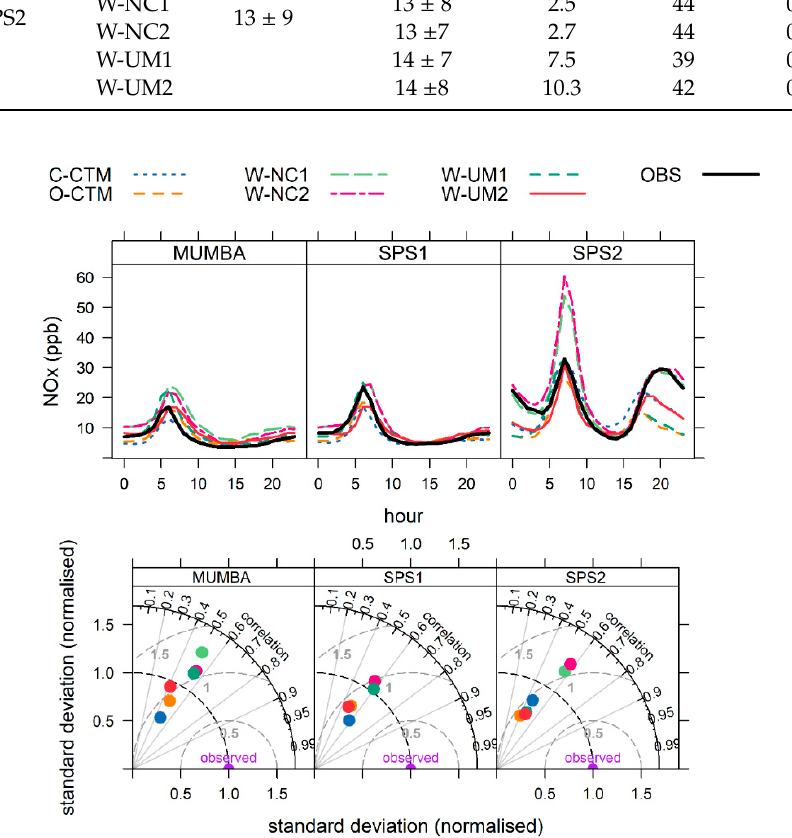
Figure A1. Composite diurnal cycles for observed and modelled hourly average NO x concentration in ppb during each campaign (upper panel) and Taylor diagrams for hourly NO x from each campaign period (lower panel).